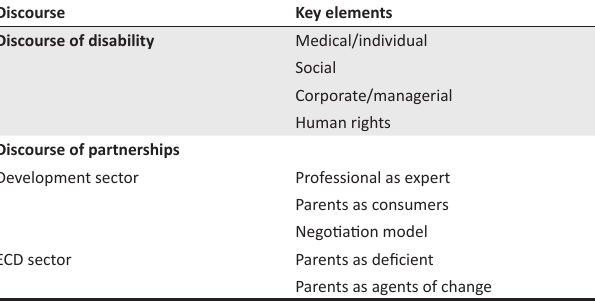
TABLE 1: Discourses shaping parent–professional partnerships. Discourse Key